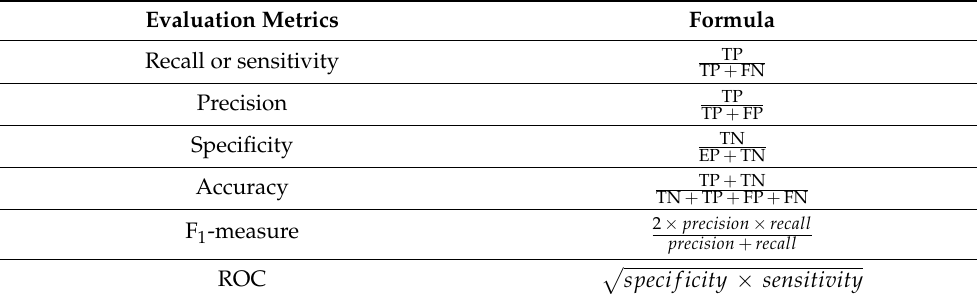
Table 2. Evaluation